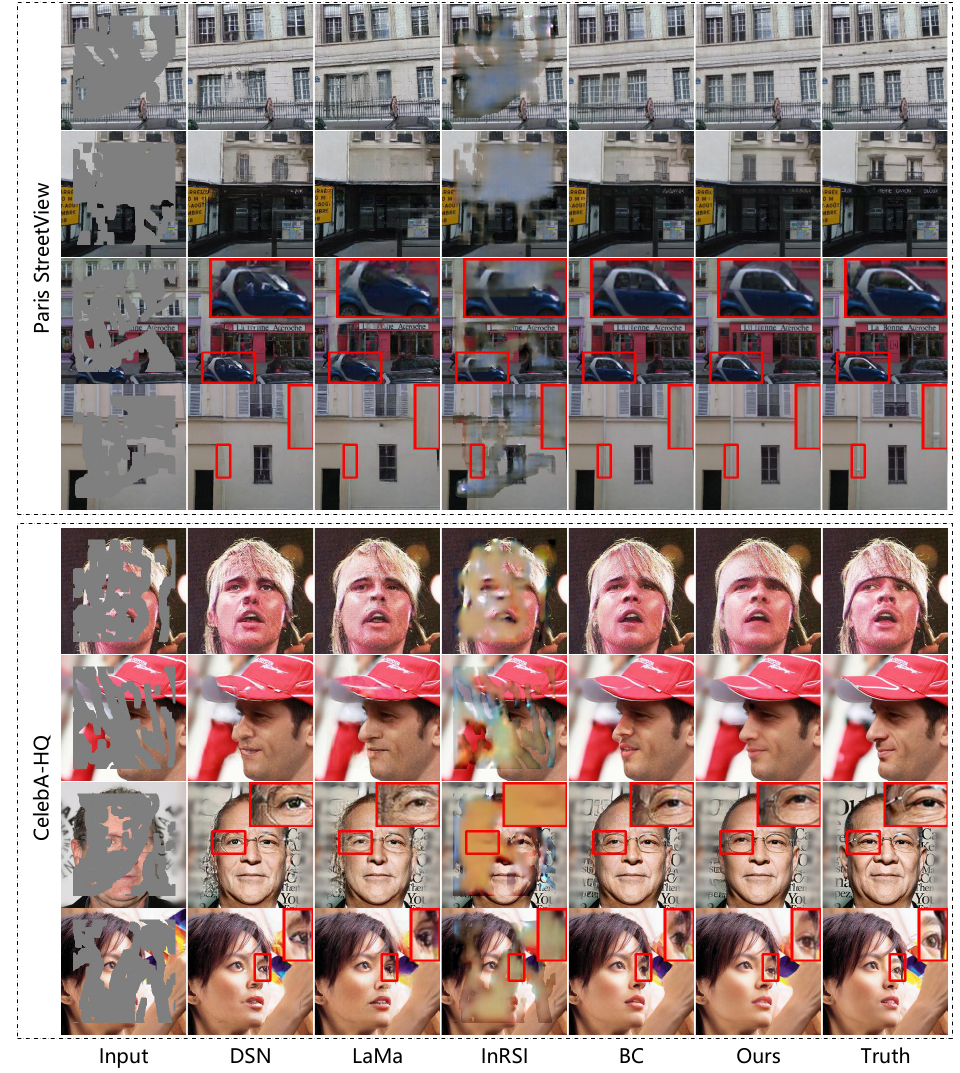
Figure 6. Visualization results with DSN [5], LaMa [44], InRSI [2], BC [43], and ours on two natural datasets. Local details of the results are displayed in red boxes, and it is recommended to zoom in for details.